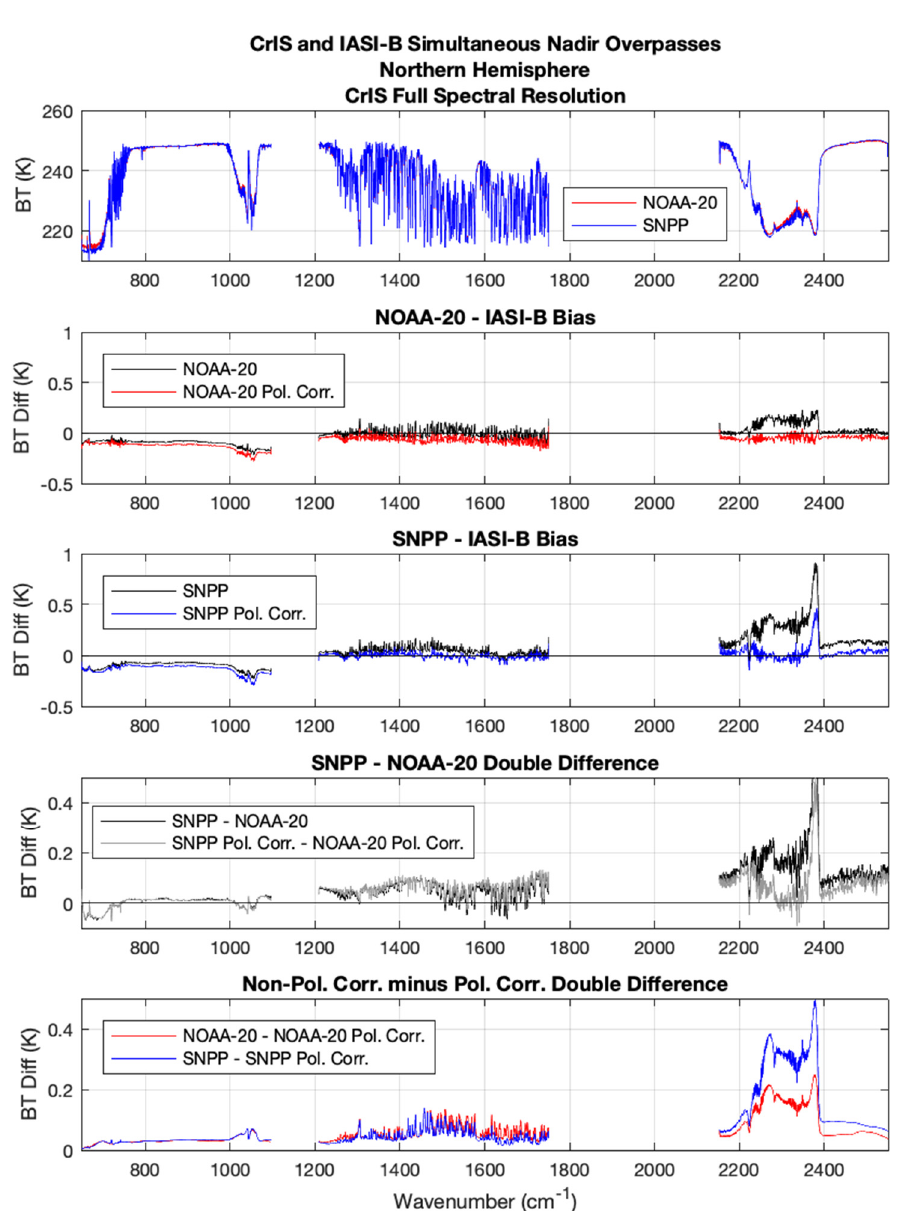
Figure 24. The impact of polarization correction on a comparison of each SNPP and NOAA-20 CrIS with METOP-B IASI. The top panel shows the mean scene brightness temperature measured by NOAA-20 and SNPP CrIS. The second and third panels from the top show the CrIS—IASI-B differences, for NOAA-20 and SNPP CrIS, respectively, and the (SNPP CrIS—IASI-B)—(NOAA-20 CrIS—IASI-B) double difference is provided in the fourth panel from the top. The bottom panel shows the total effect of the polarization correction on the subset of CrIS data used in the comparison.